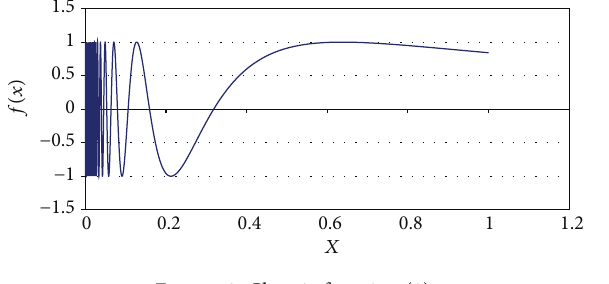
Figure 3: Chaotic function (9).